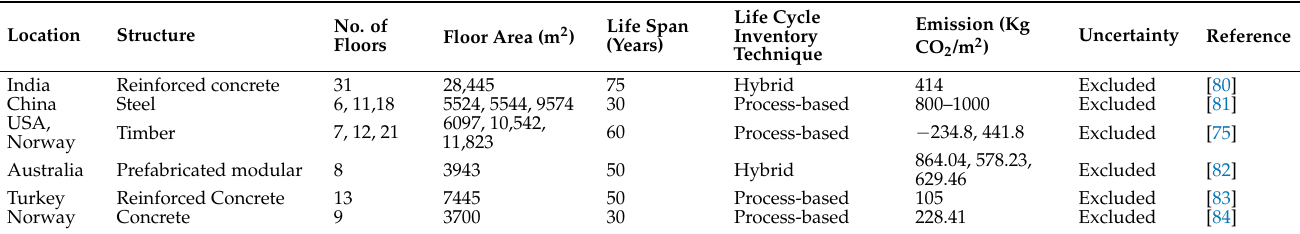
Table 2. Comparison of emissions of high-rise residential